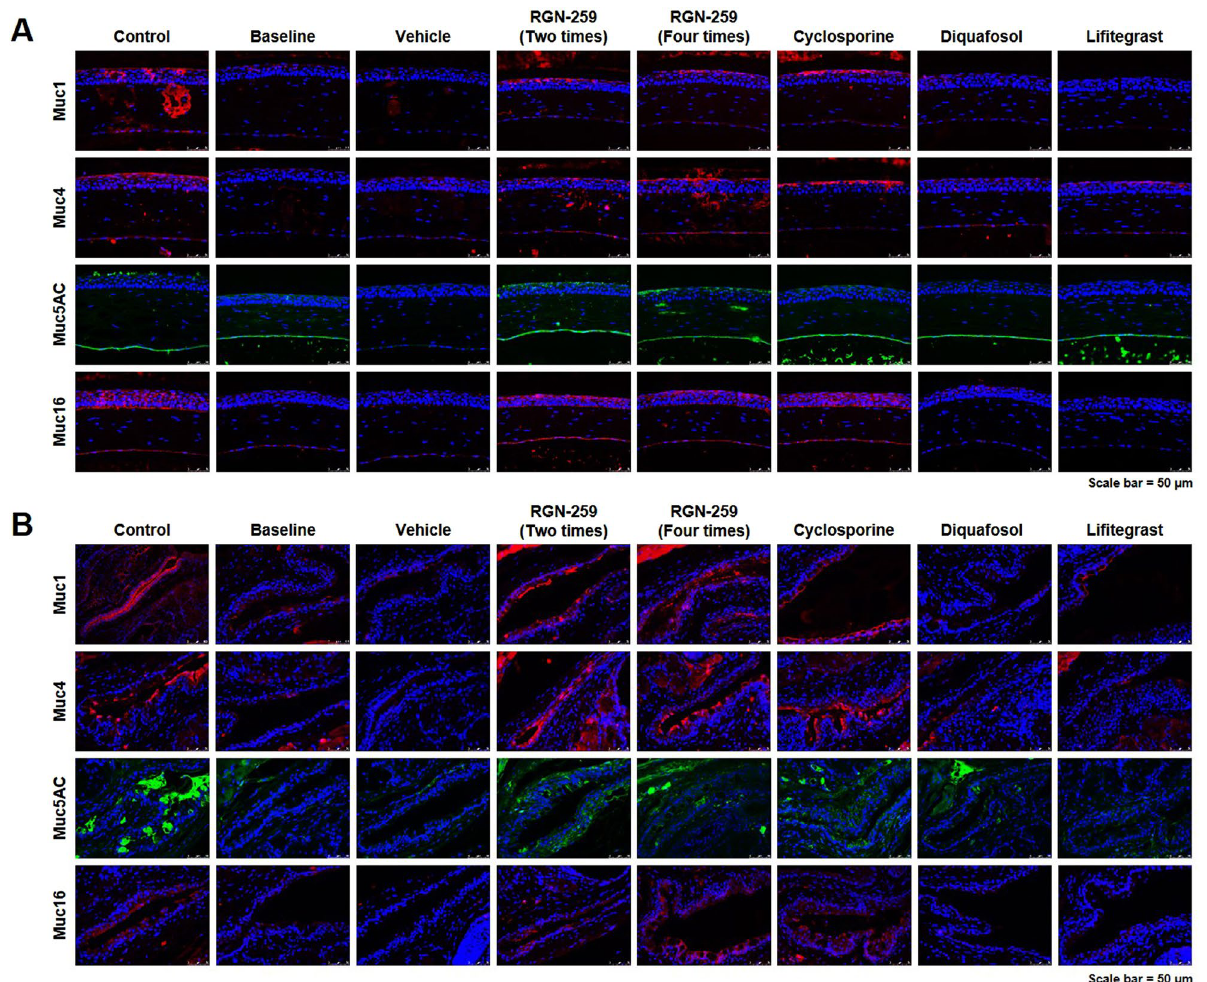
Figure 8. RGN-259 induced expression of mucins comparable to that of CsA. Immunofluorescence staining of mucins in the eyes of mice. ( A ) The expression of mucins in the cornea. ( B ) The expression of mucins in the conjunctiva. Scale bar = 50 μ